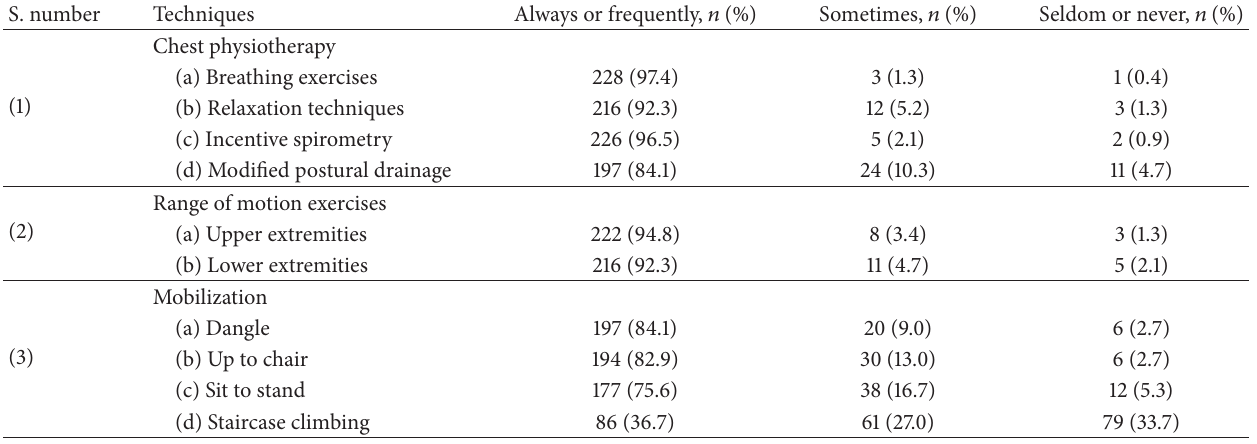
Table 7: Physiotherapy interventions used on the 3rd postoperative day.